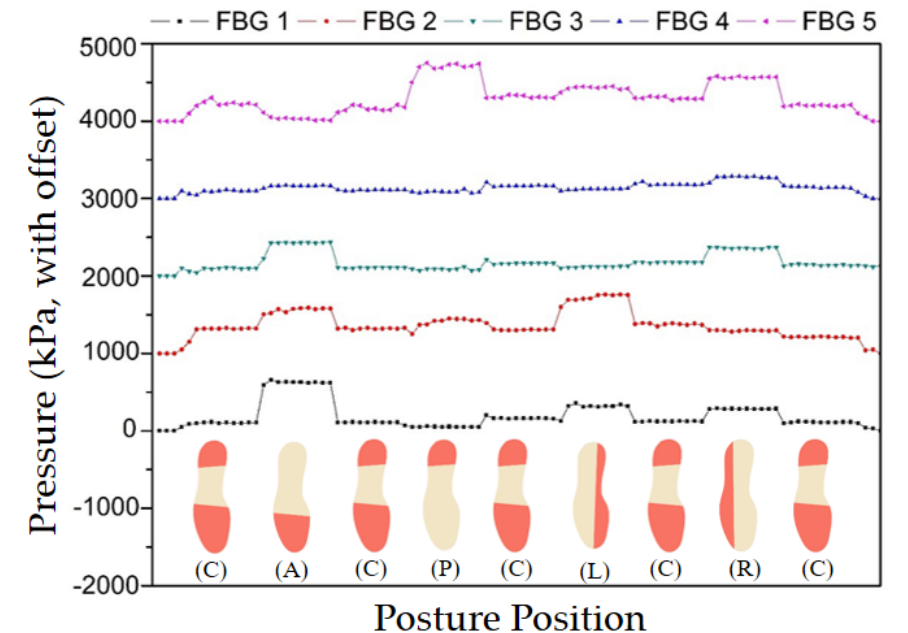
Figure 6. Representation of the pressures detected during the BCM displacements (the pressure increasing on each foot location is colored in red in the scheme).